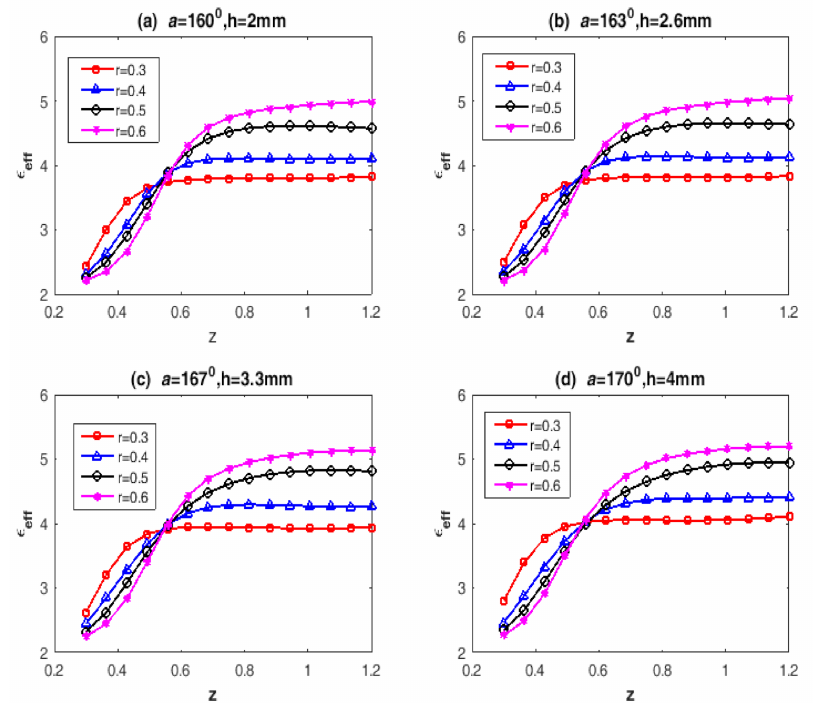
Figure 8. E ff ect of billet size ratio on the e ff ective strain in the billet with varying reduction ratios, punch angle ( a ) and land height (h) at: ( a ) a = 160 ◦ , h = 2.0 mm; ( b ) a = 163 ◦ , h = 2.6 mm; ( c ) a = 167 ◦ , h = 3.3 mm; and ( d ) a = 170 ◦ , h = 4.0